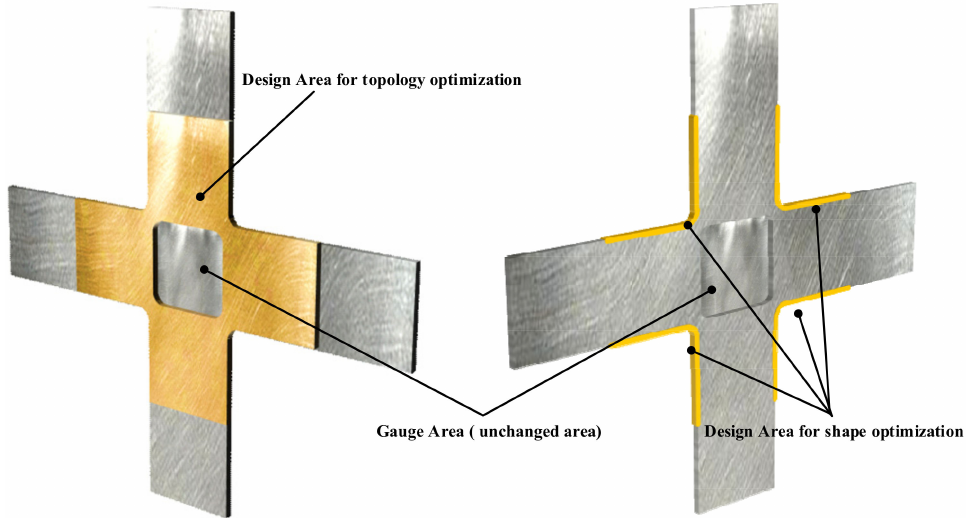
Figure 3. The design area optimised with topology optimisation and shape